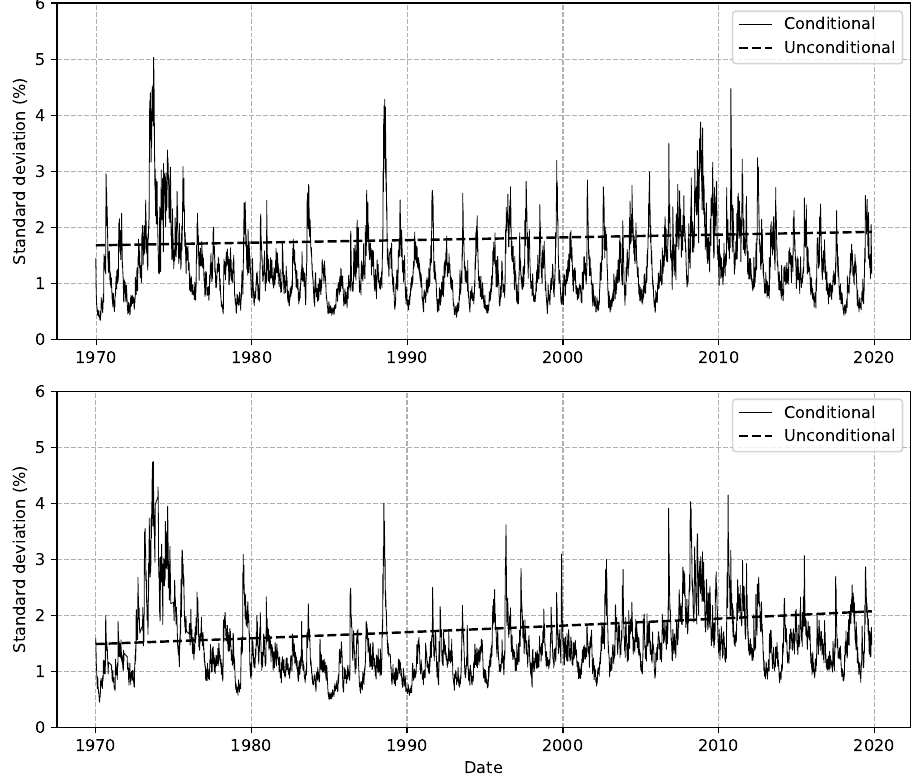
Figure 8. Predicted conditional and unconditional standard deviations for corn ( top panel ) and wheat ( bottom panel ),